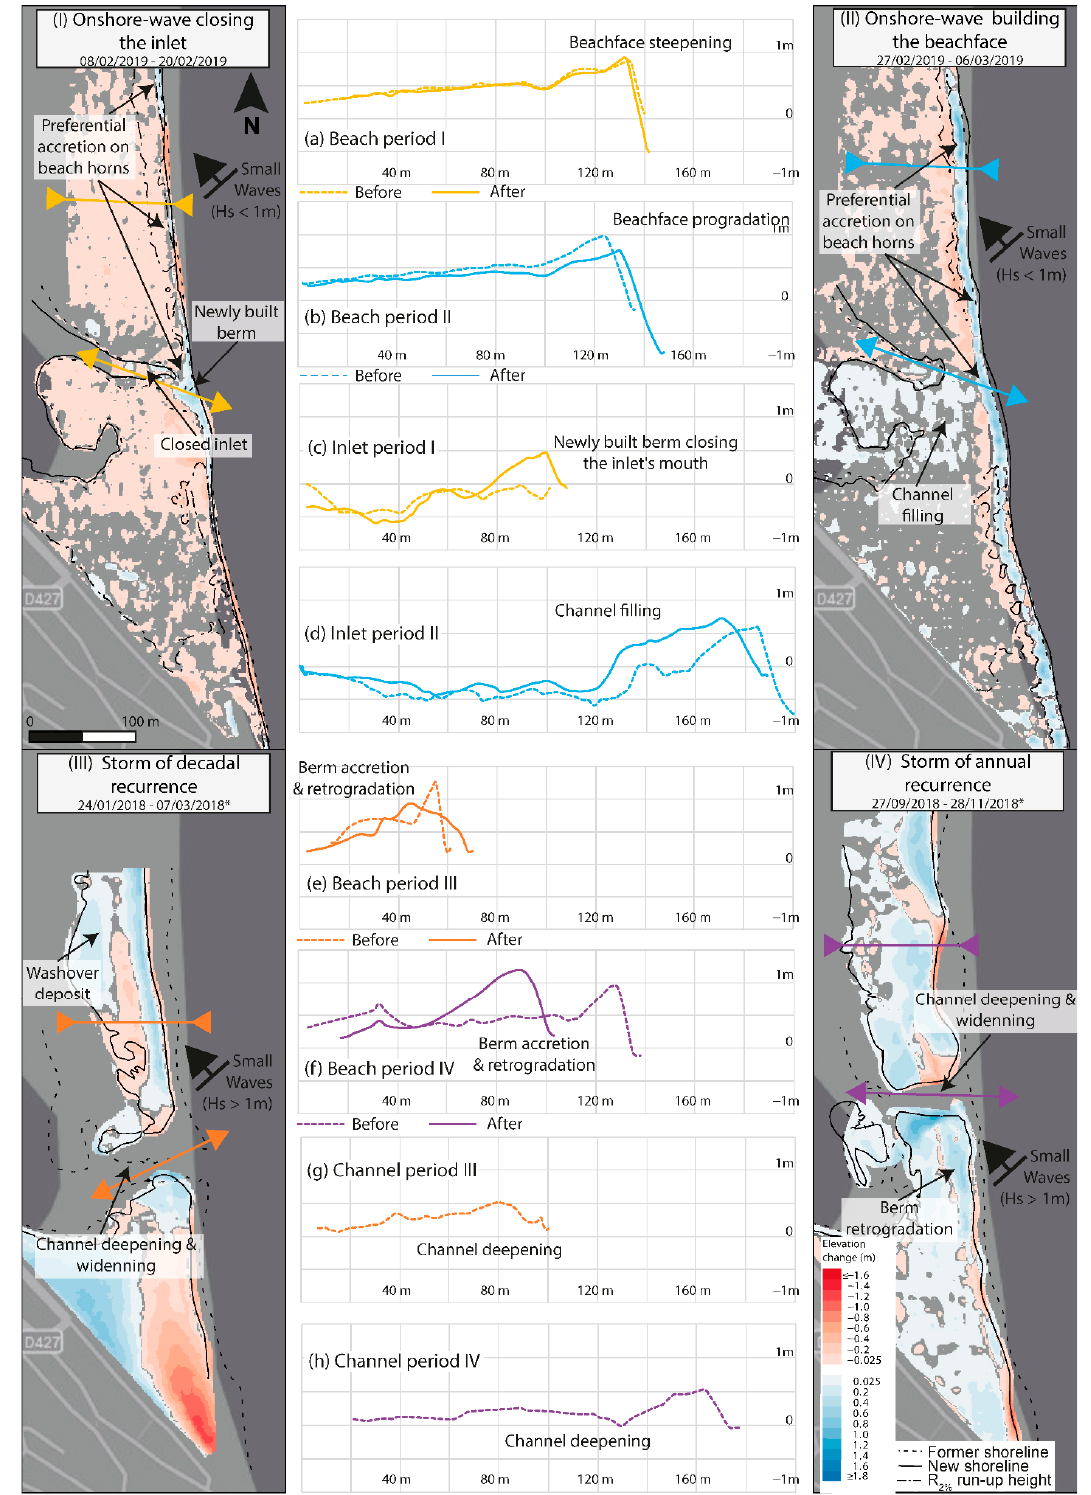
Figure 10. Morphological evolution of La Franqui beach, during periods of onshore-wave action closing the inlet ( I , a , c ) and building of the beachface ( II , b , d ) and for a storm of decadal recurrence at the La Franqui ( III , f , h ) and storm events of annual recurrence ( IV , f , h ). Dotted lines correspond to the initial profile and solid lines to the final situation. The beach is completely submerged during storms ( III , IV ) and the channel is too deep to be surveyed (>1.2